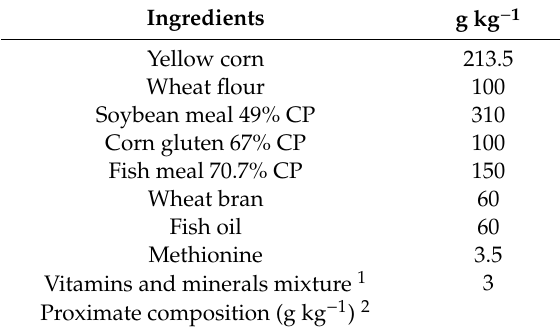
Table 1. Feed formulation and proximate composition (g kg − 1 on a dry weight